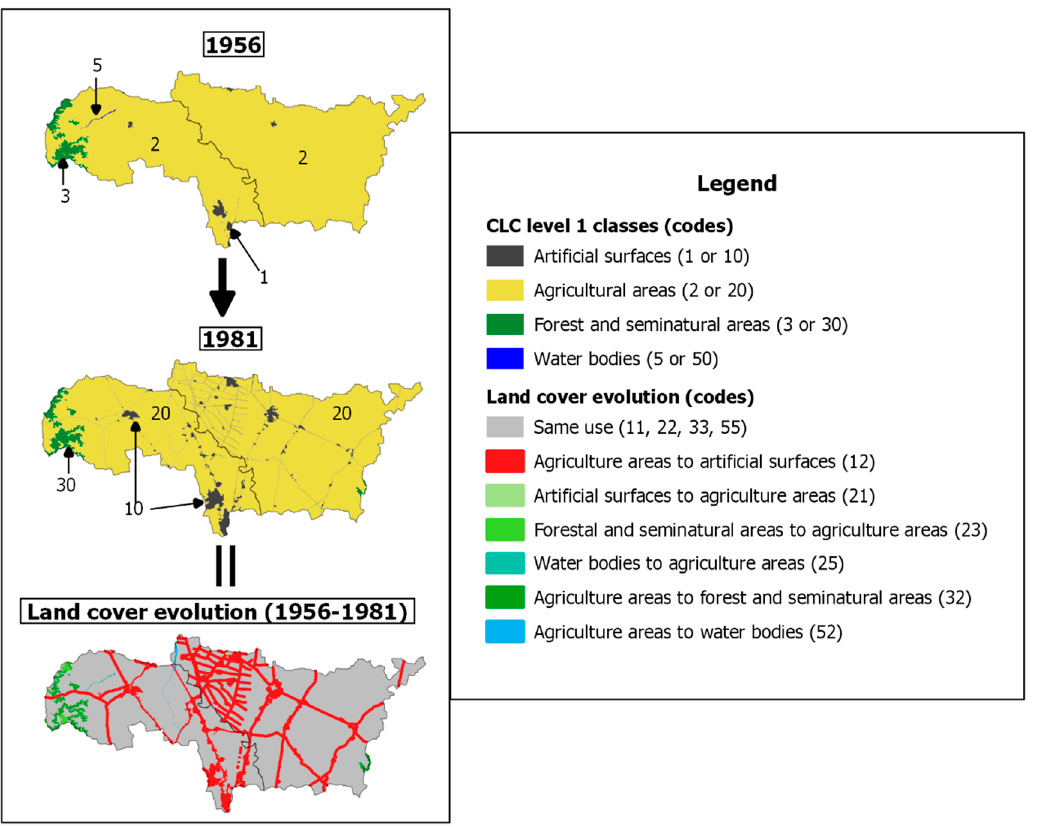
Figure 3. Land cover changes methodology.